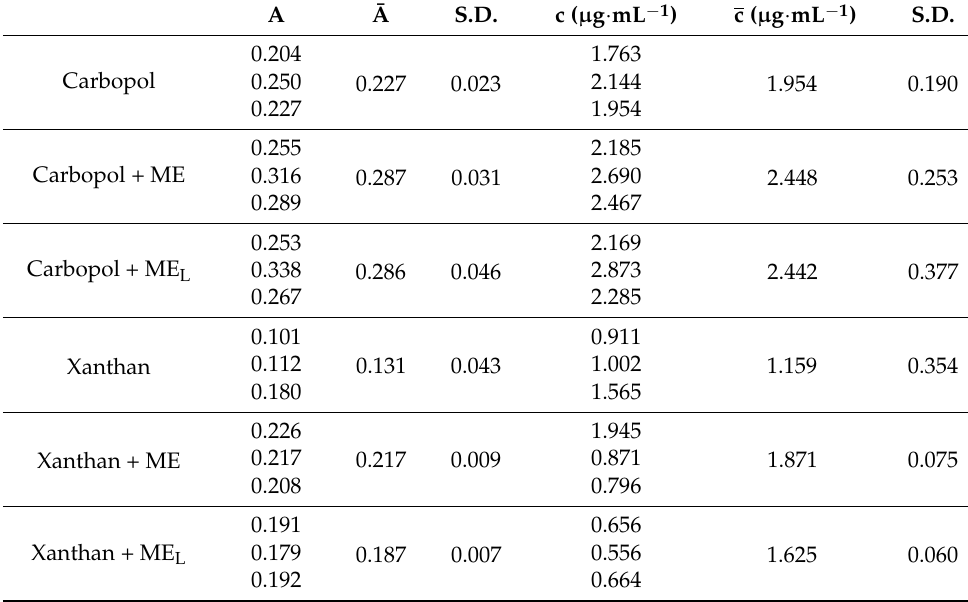
Table 6. The concentration c ( µ g mL − 1 ) of tretinoin determined in the skin macerate after the ex vivo permeation study of the tested